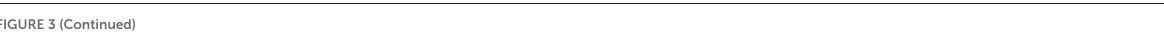
FIGURE4 Results of the probabilistic sensitivity analysis. (A) scatter plot (above). (B) cost-effectiveness acceptable curve (below). NN, first-line nedaplatin-based chemotherapy followed by second-line nivolumab; NT, first-line nedaplatin-based chemotherapy followed by second-line tislelizumab; ND, first-line nedaplatin-based chemotherapy followed by second-line docetaxel; CN, first-line standard chemotherapy followed by second-line nivolumab; CT, first-line standard chemotherapy followed by second-line tislelizumab; CD, first-line standard chemotherapy followed by second-line docetaxel; CA, first-line camrelizumab combined with chemotherapy followed by second-line docetaxel; PE, first-line pembrolizumab combined with chemotherapy followed by second-line docetaxel; SI, first-line sintilimab combined with chemotherapy followed by second-line docetaxel; SU, first-line sugemalimab combined with chemotherapy followed by second-line docetaxel; QALY, quality-adjusted life year; GDP, 2021 per capita Gross Domestic Product.